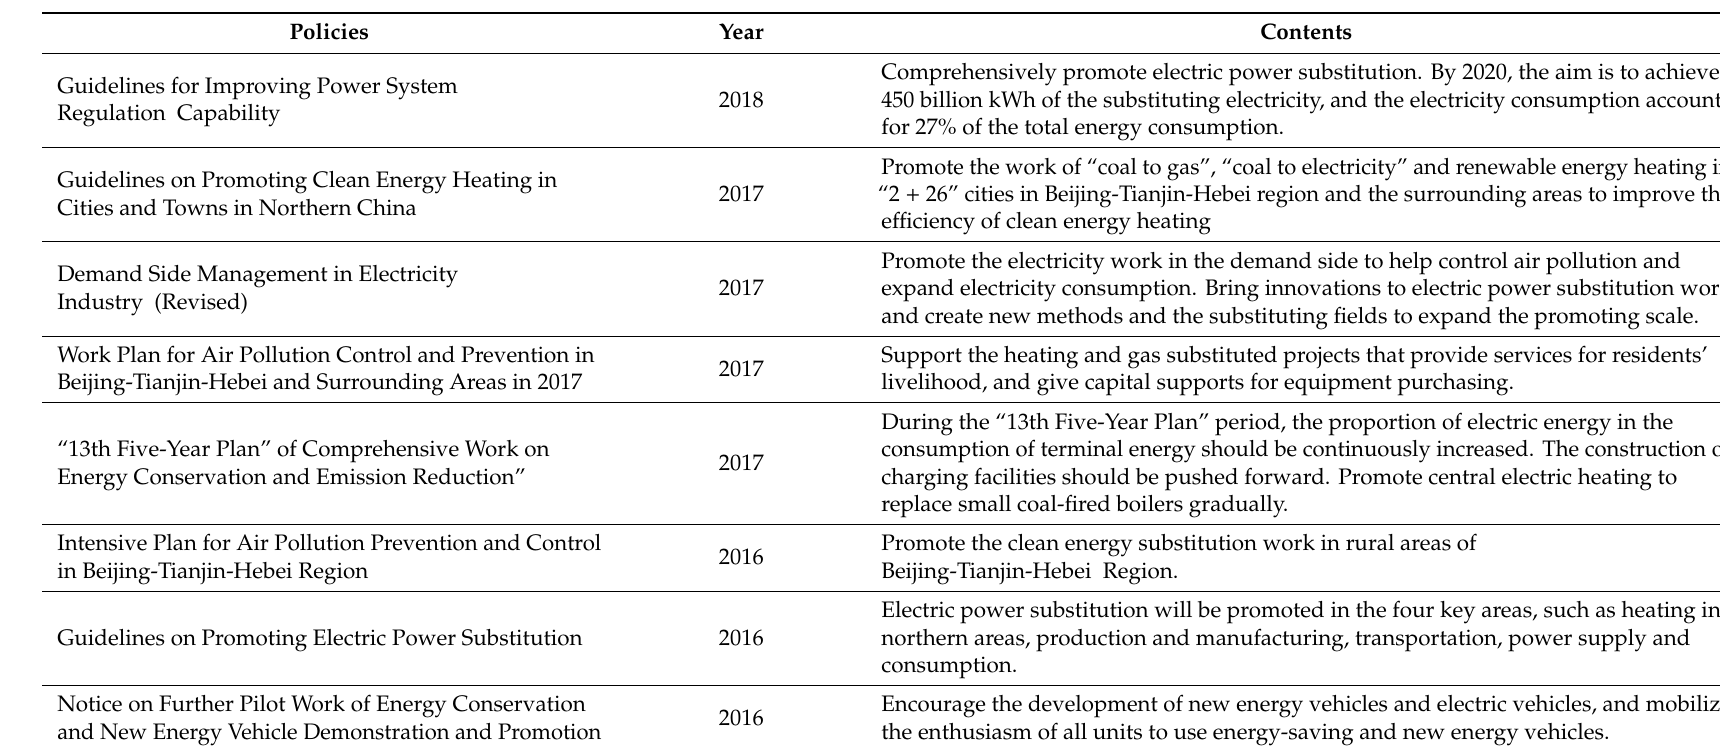
Table 2. Policies supporting electric power substitution